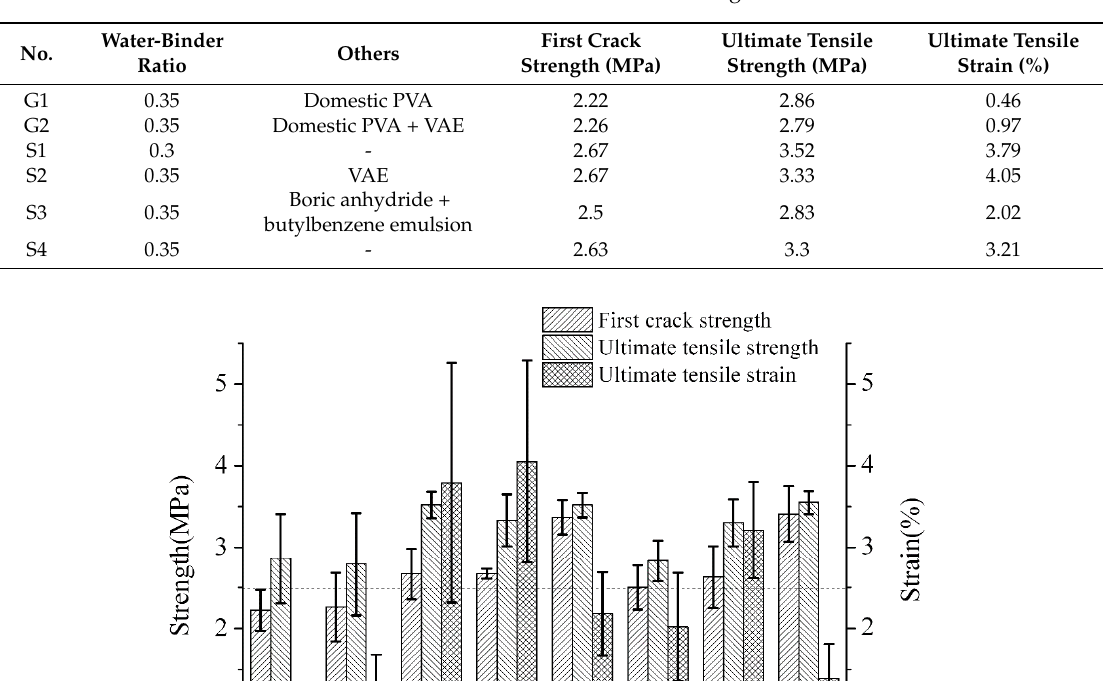
Table 10. Mixture ratio of tensile testing.